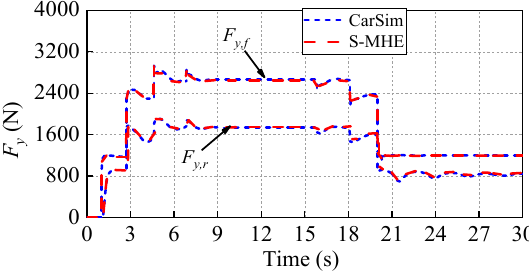
Figure 21. Lateral tire forces estimated by S-MHE.